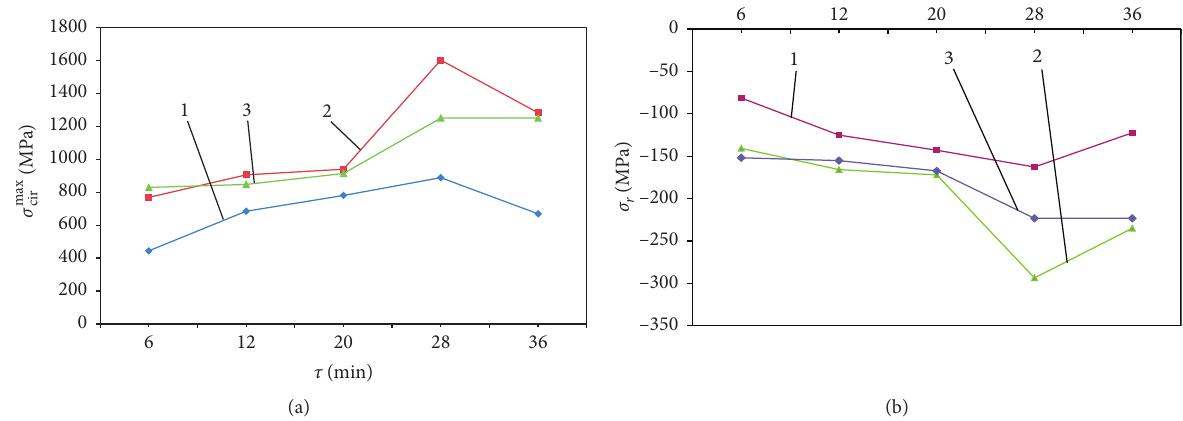
Figure 6: Dependence of the magnitude and sign of the residual stresses in the hardened layer after VCH on the processing time and weight of the hardened tool. 1, 3.5kg; 2, 4.5kg; 3, 7.5kg. (a) Circular compressive stresses σ max s